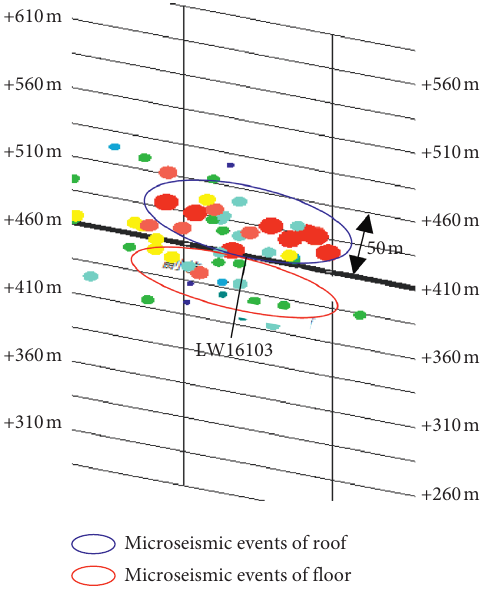
Figure 13: Profile analyses of microseismic